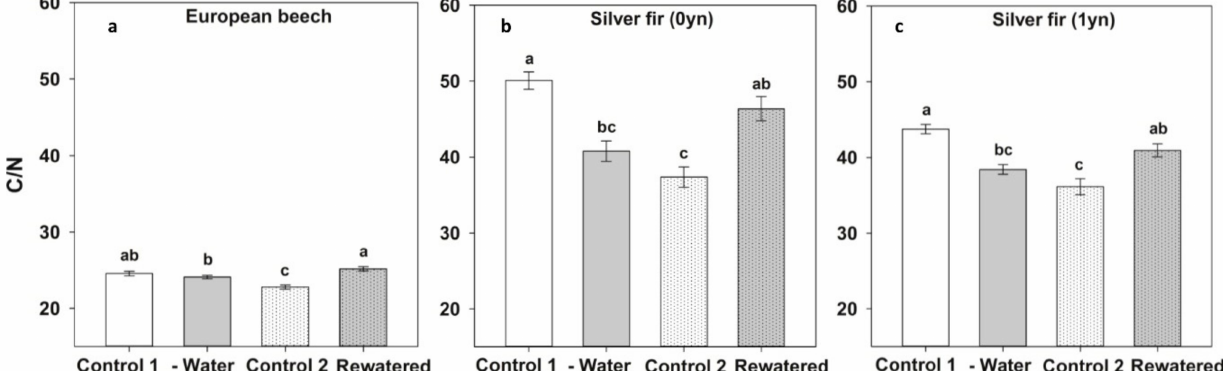
Figure 6. Foliar C/N ratio of beech ( F. sylvatica L.) ( a ) and silver fir ( A. alba Mill.) ( b , c ) seedlings. 0yn, current − year needles; 1yn, one − year needles. Significant differences between controls and treatments are indicated by different letters ( p ≤ 0.05; n = 80). Values shown are means ±